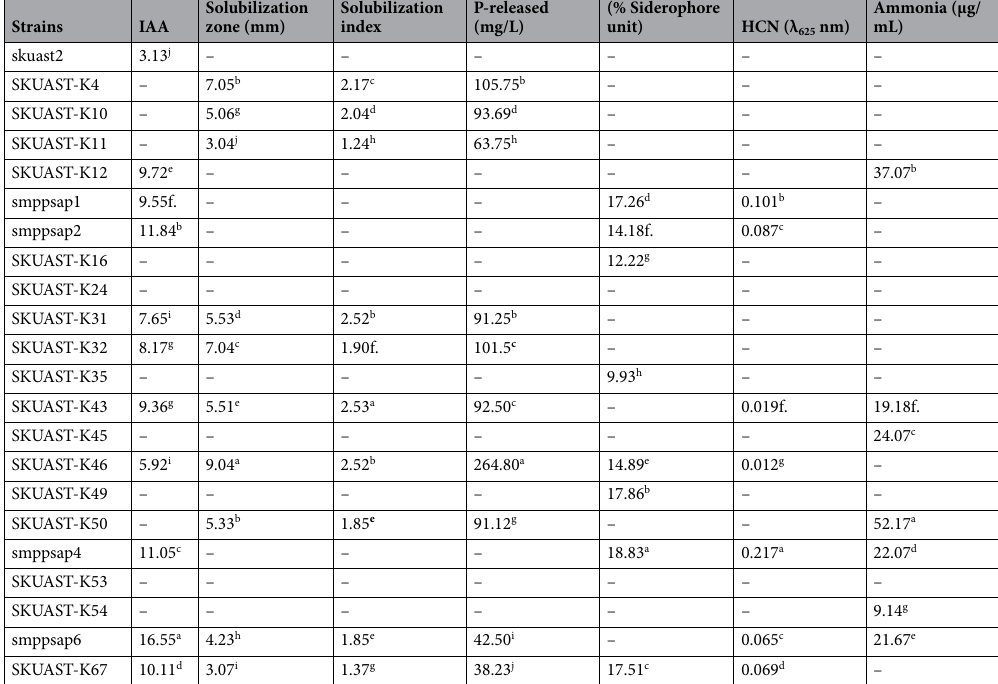
Table 4. Plant growth-promoting attributes of the isolated microflora. Means in the column with same letter didn’t differ by Tukey’s